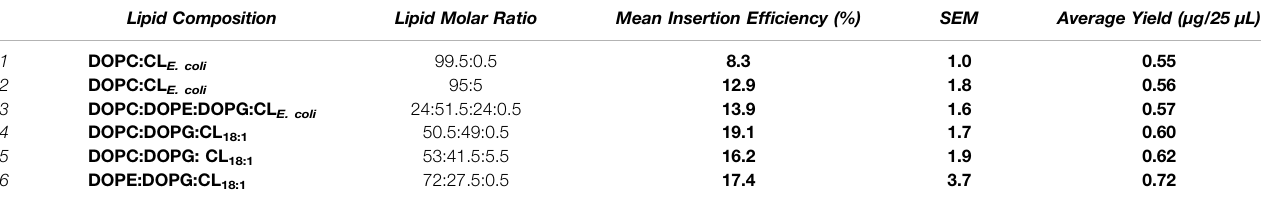
TABLE2| LipidcompositionsandtheirrespectivemolarratiosinvestigatedforLeuTspontaneousinsertioninPURExpress ® 1 – 6.Meaninsertionef fi ciencies(%)andaverage total yields with each condition are shown for each lipid condition tested. The total protein yields after puri fi cation are presented in Supplementary Table S3 . The average protein yield after sucrose gradient puri fi cation is consistent with the total yields immediately after IVTT reaction, so protein is not lost during puri fi cation steps. The average total yield and mean insertion ef fi ciencies (%) were calculated from three repeats ( n = 3) except condition 6 where n = 5. Experimental errors for mean insertion are presented as SEM. Lipid Composition Lipid Molar